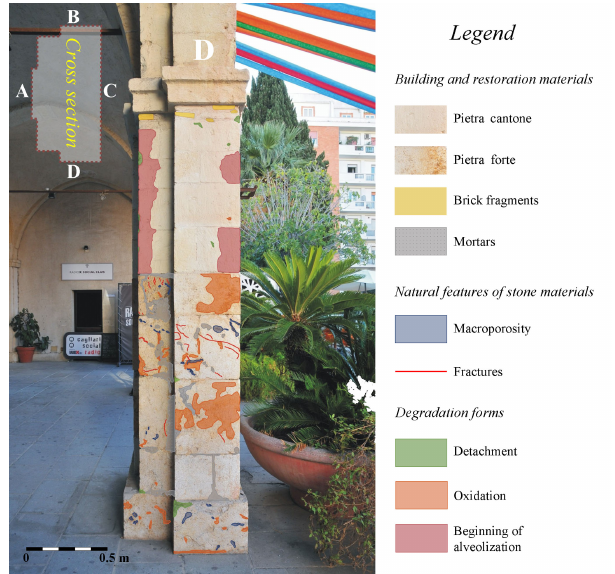
Figure 5. Map of the characteristics of the shallow building materi- als in one of the investigated faces of the